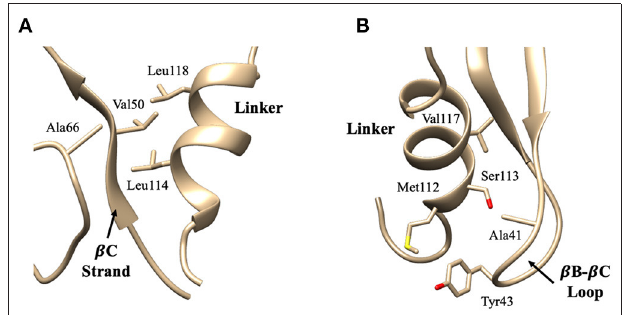
FIGURE 4 | Key interaction pairs between the PDZ domain and the linker. (A) shows the hydrophobic core forming between the PDZ β C-strand/ α A- β D loop and the short helix of the linker. Key interaction pairs Val50-Leu114 and Ala66-Leu114 listed in Table 1 can be visualized in (A) . (B) shows the hydrophobic core forming between the PDZ β B- β C loop and the short helix of the linker. Key interaction pairs Tyr43-Ser113 and Ala41-Val117 listed in β can be visualized in (B) .